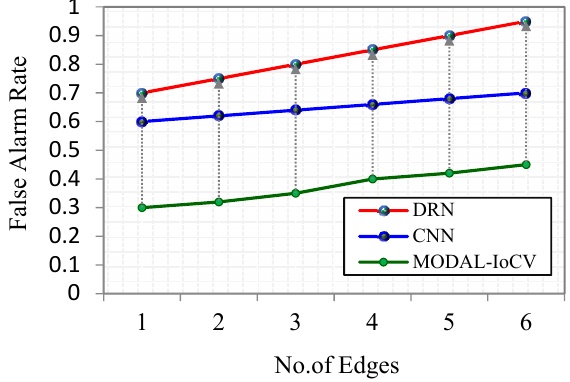
Figure 14. Number of edges vs. false alarm rate.